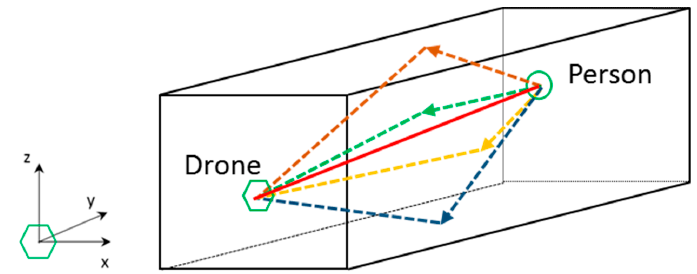
Figure 5. Direct (black) and reflected (colored) acoustic signals in an indoor space.